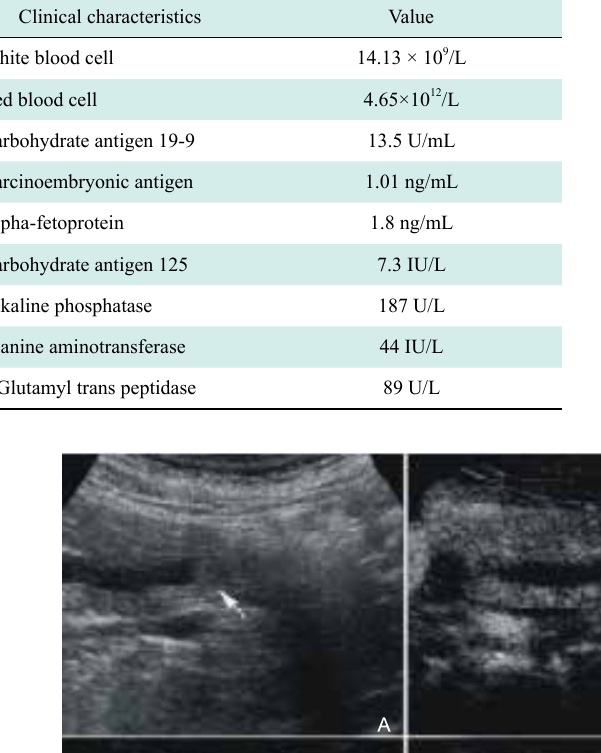
Table 1 Laboratory data at initial hospitalization Clinical